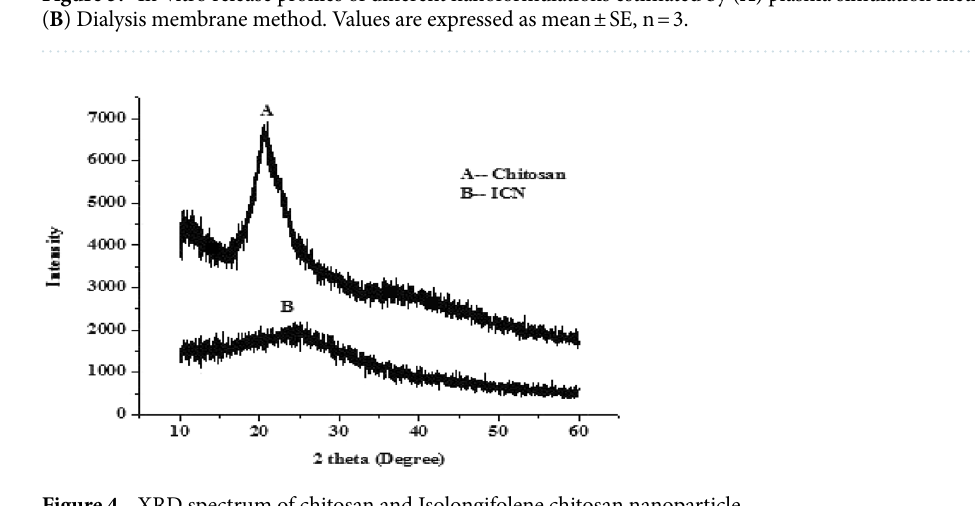
Figure 4. XRD spectrum of chitosan and Isolongifolene chitosan